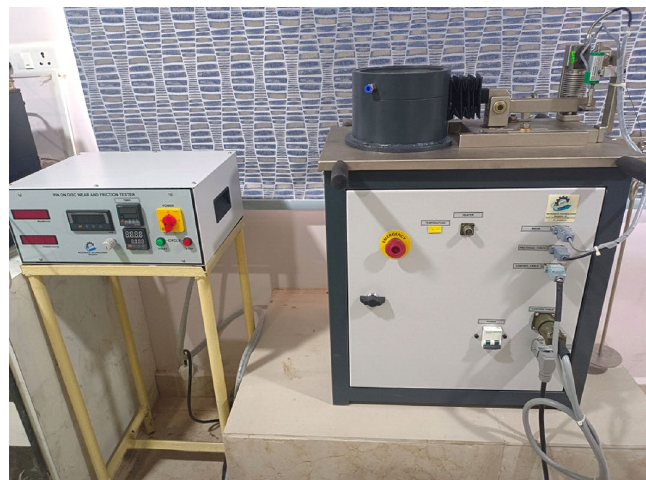
Figure 2. Experimental setup of pin on disc wear testing equipment.